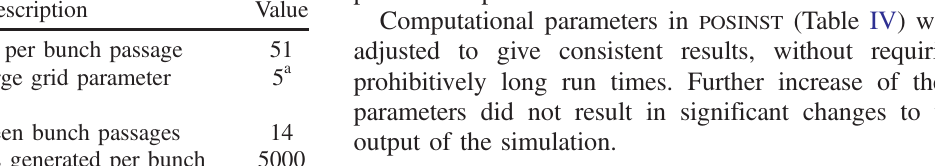
) and the efficiency of the RFA ( ε ), macro dir ) and angle ( θ ). In addition, the macroelectron can generate low energy in in ). Secondaries which do not contribute to the collector signal sec